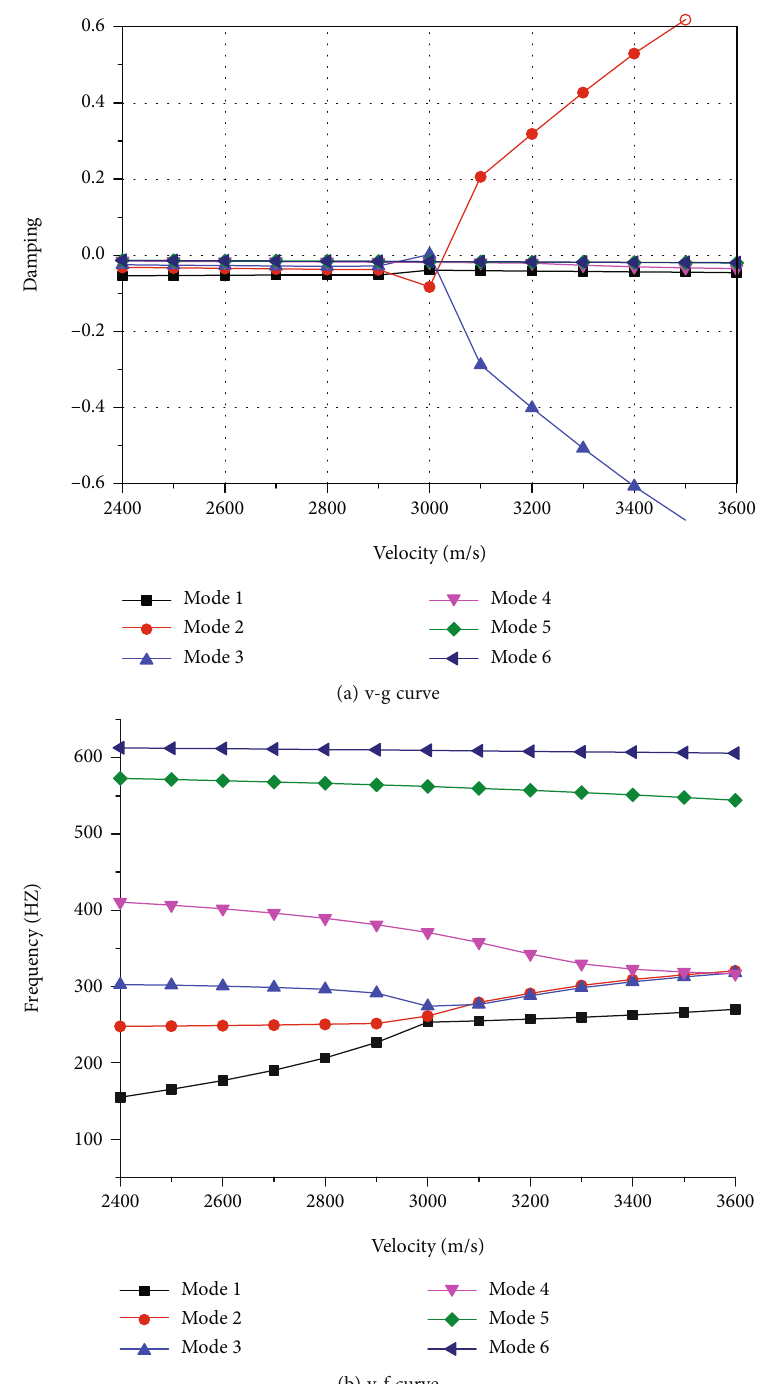
Figure 18: V-g and v-f curves for optimal